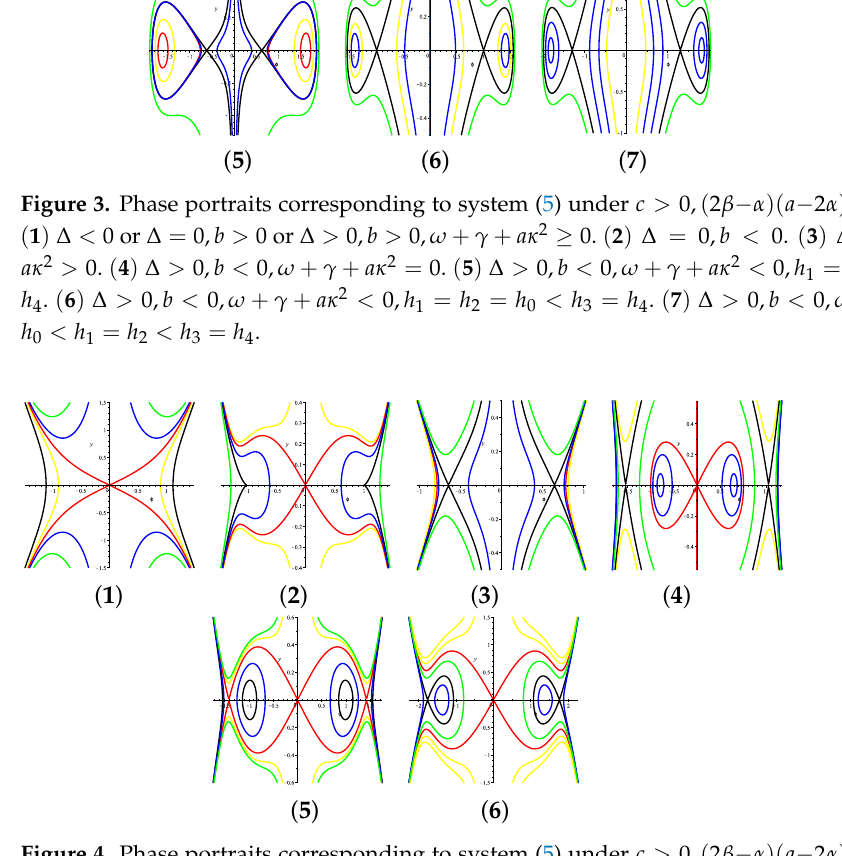
Figure 4. Phase portraits corresponding to system (5) under c > 0, ( 2 β − α )( a − 2 α ) > 0, a − 2 α <